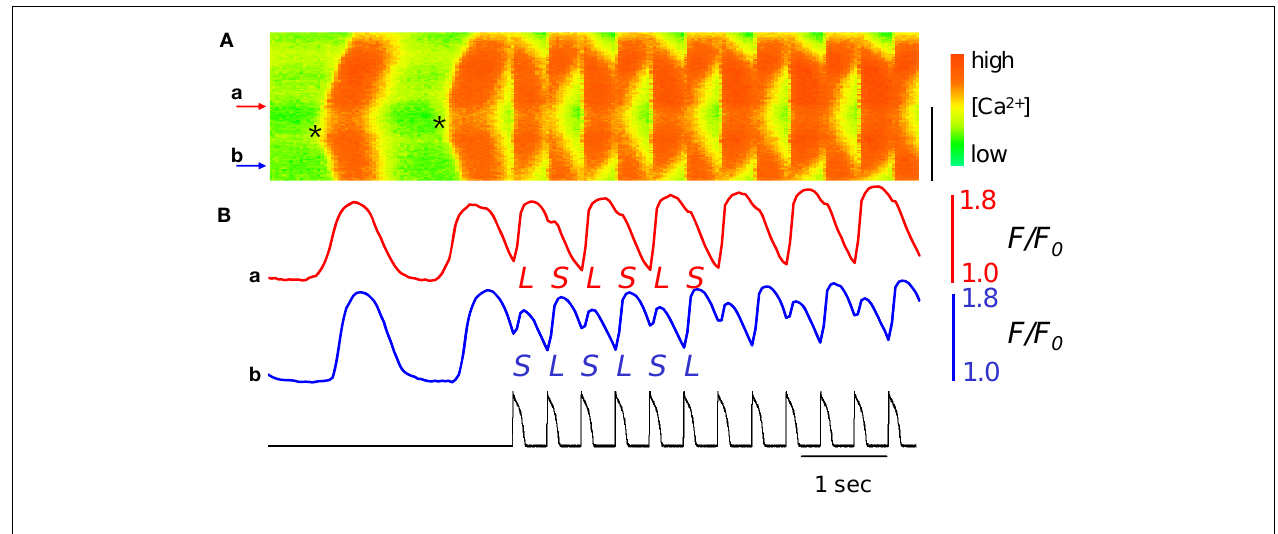
the middle of the cell (near site a ) and propagate outward. Beginning during the second Ca 2 + -wave, a repeating AP clamp was used to rapidly pace the cell (with waveform and timing as shown in (B) , black trace), causing a marked subcellular alternans pattern. (B) The time series of Ca 2 + -fluorescence at sites a and b show Ca 2 + -alternans during the AP clamp pacing to be out-of-phase at these two points. Adapted from Xie andWeiss (2009).